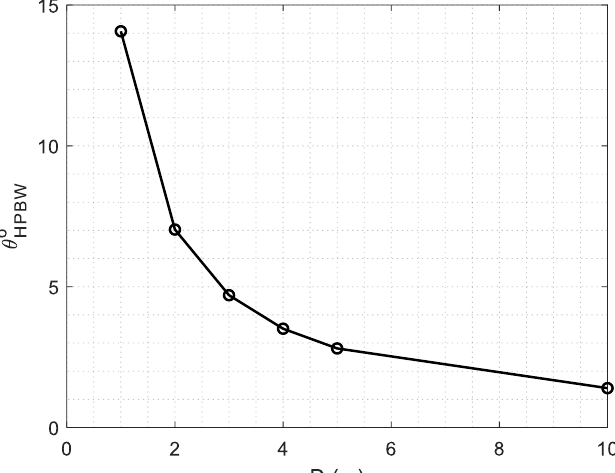
(degree)) as a function of the antenna HPBW diameter (D